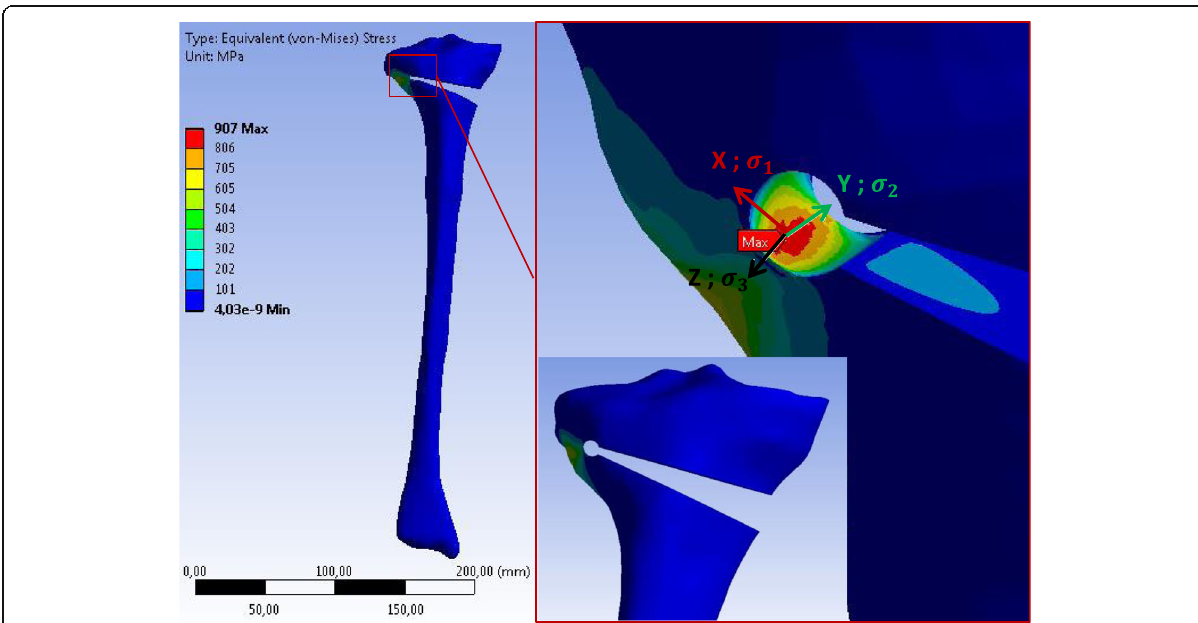
Fig. 11 Equivalent (von-Mises) stress in the specimen SWHE obtained with 3D linear FEA: Only the result for case study H is represented. The stress values correspond to an opening angle of 10°. The specimen has been slightly rotated in the zoom-view on the right to show the location of the reference point where the equivalent (von-Mises) stress was